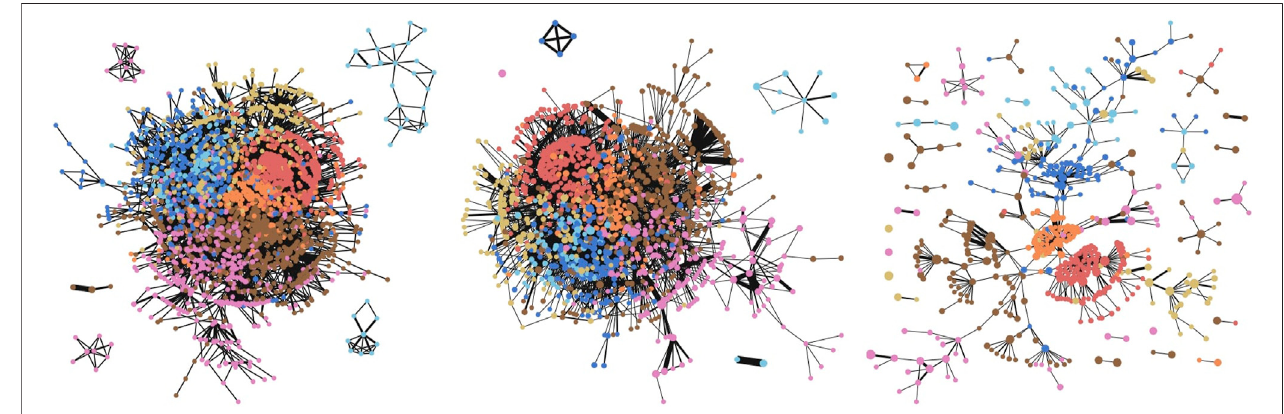
FIGURE 6 | Ablation for different types of unsupervised lenses (identity, untrained DGI, trained DGI). The trained DGI model signi fi cantly improves the quality of the visualisations.